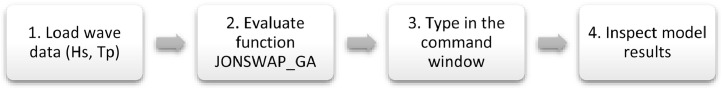
Flow diagram for applying the MATLAB code of the GA model.